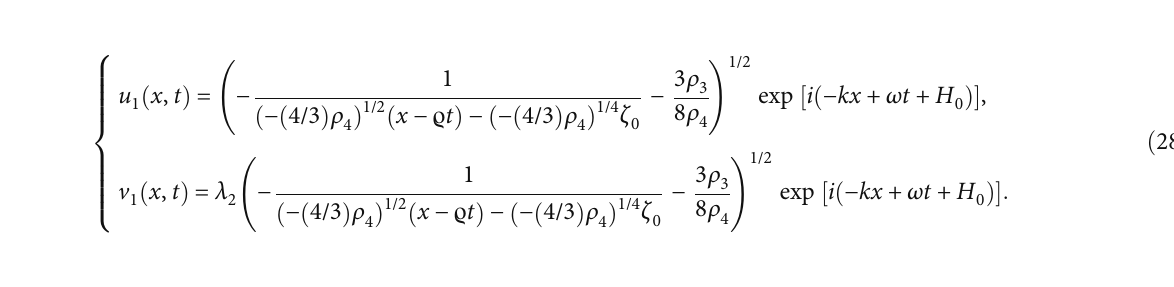
ð t , x Þ with a = b = c = d = 1, f 1 1 1 1 1 = γ = δ = − 1, α = 3, and β = 1 2 2 2 2 2